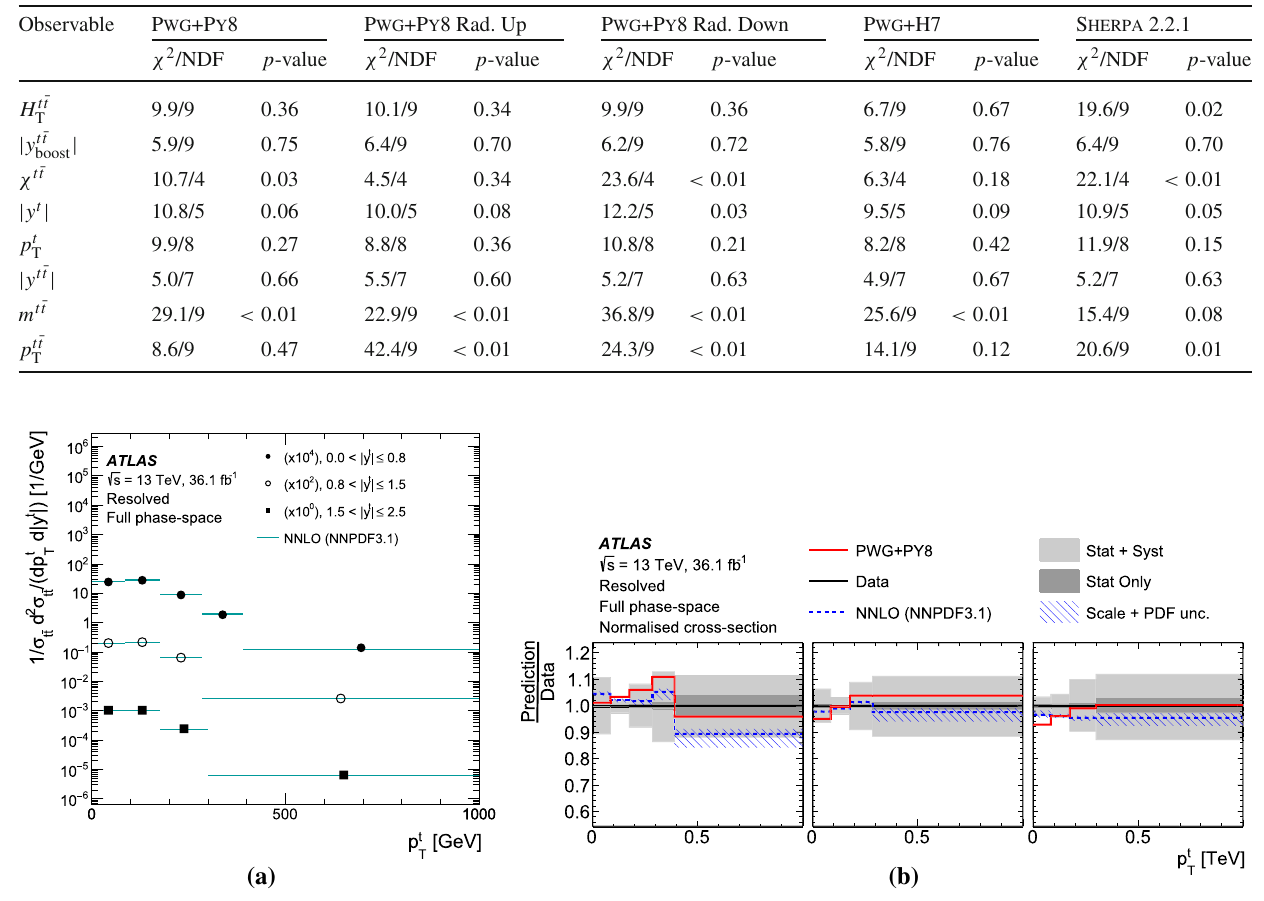
calculated using the covariance matrix of the measured spectrum. The NDF is equal to the number of bins in the distribution